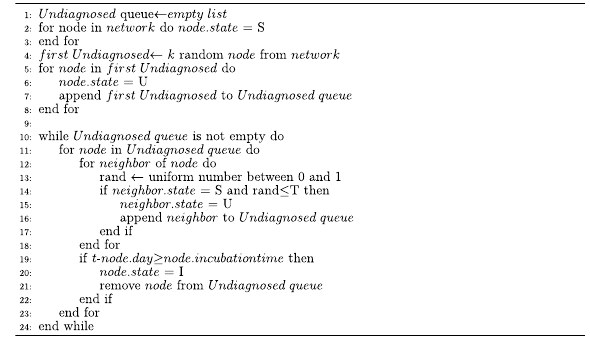
Algorithm 1. Epidemic dynamic in commute